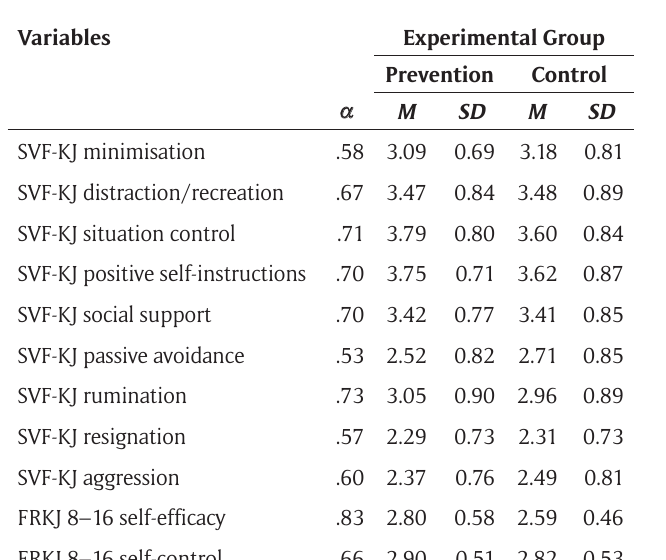
Table 1: Descriptive Statistics: Means and Standard Deviations for the Control